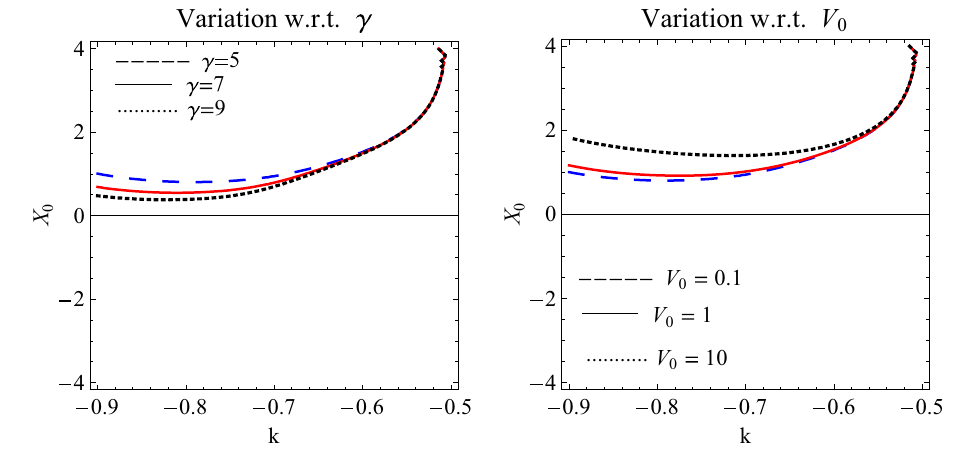
Figs. 1 and 2 Show the variation of slope X 0 of outgoing radial null geodesic at r = 0 in Penrose diagram as a function of the equation of state parameter k for different values of α and β respectively in Brans–Dicke gravity’s rainbow. In Fig. 1 the other parameters are fixed